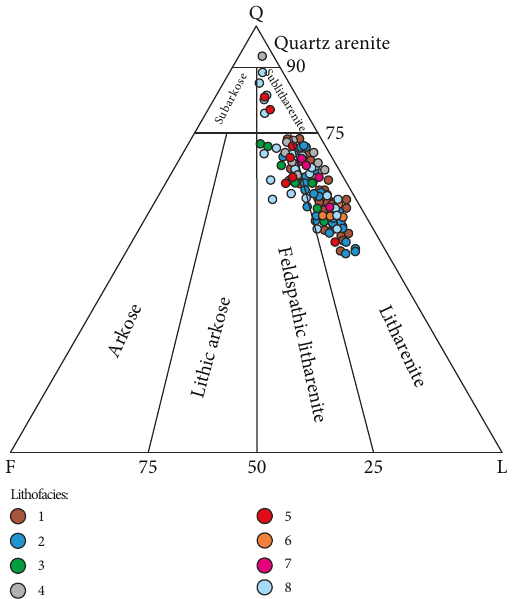
Figure 6: Sandstone-type triangular diagram of the di ff erential densi fi cation